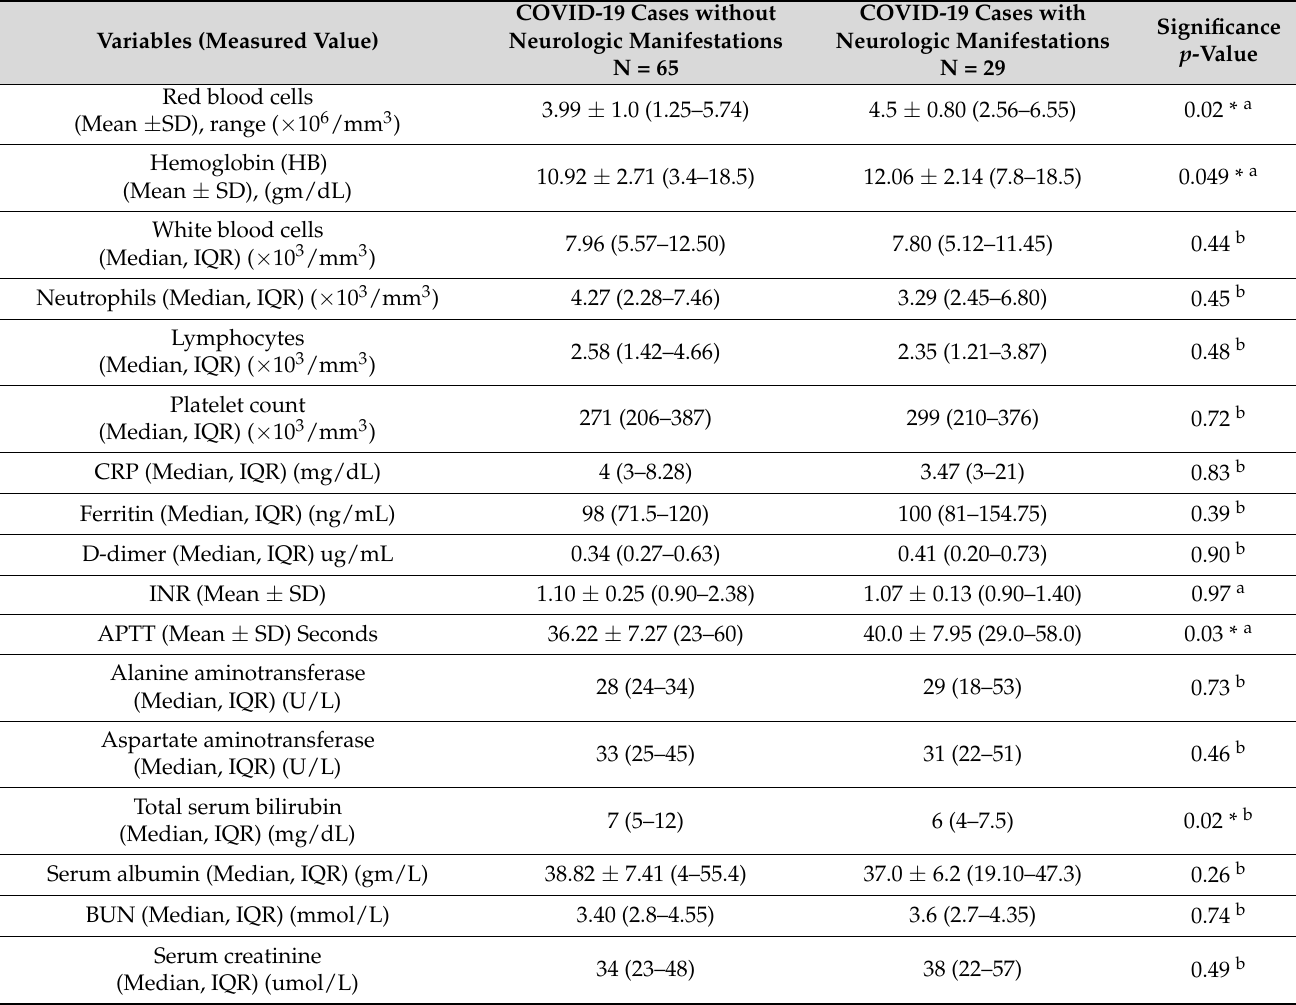
Table 4. Comparison of laboratory findings between pediatric COVID-19 cases with and without neurological